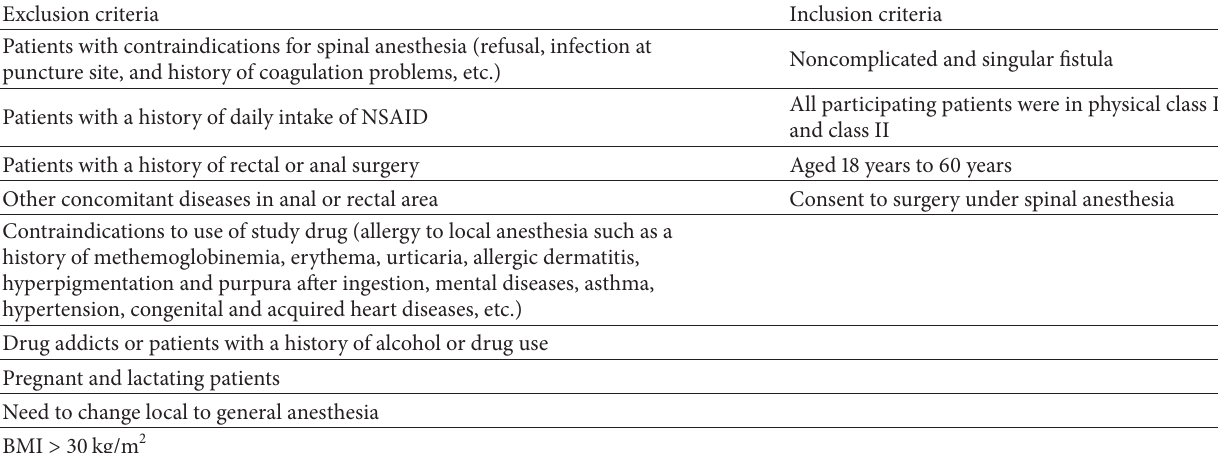
Table 1: Study inclusion and exclusion